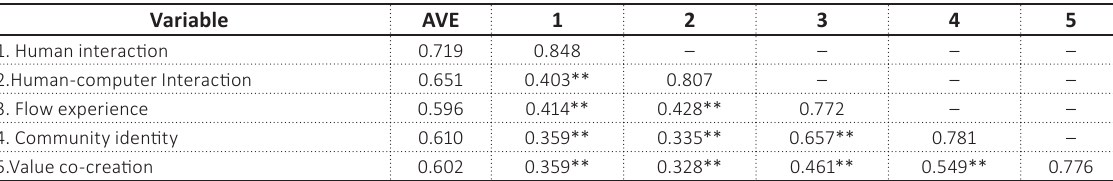
Table 2. Factor correlation coefficients and discriminant